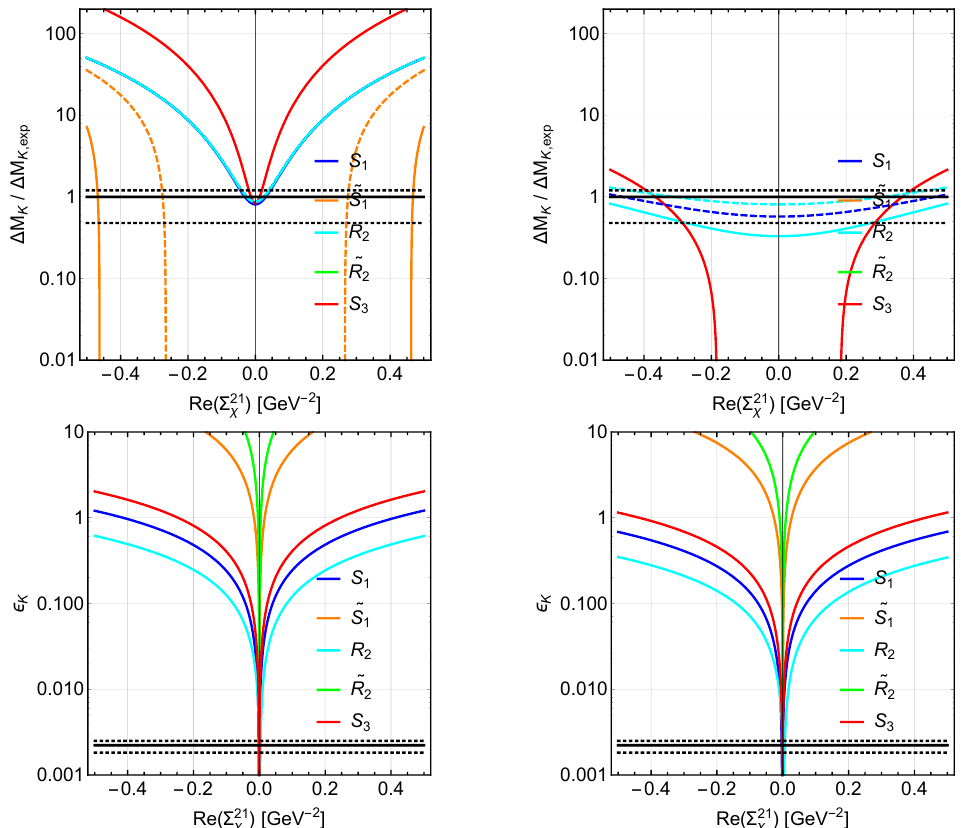
Figure 9. The dependence of the short-distance part of (cid:1) M K = (cid:1) M K; exp [upper] and " K [lower] on real parts of couplings for M LQ = 2 TeV [left] and M LQ = 20 TeV [right] for (cid:20) " 0 = 0 : 5. Further shown are the experimental measurement [black solid] and the SM prediction [black